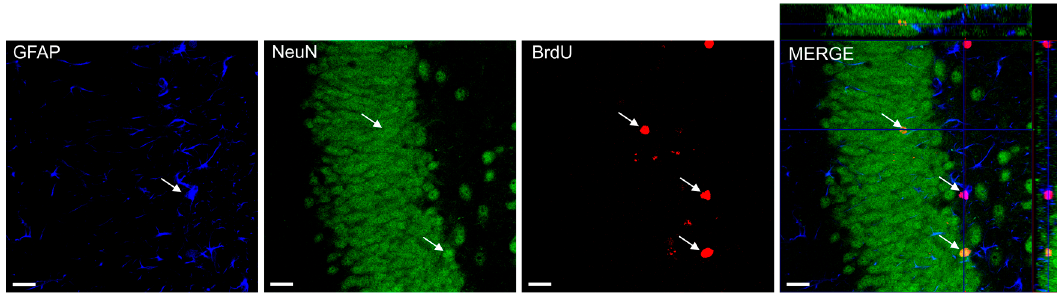
Figure 6. Bromodeoxyuridine (BrDU) positive cells in colocalization with NeuN and GFAP cells. The number of BrdU positive cells displaying astrocyte-specific (GFAP), neuron-specific (NeuN), BrDU-specific markers was determined using confocal microscopy to score the colocalization of BrdU and phenotypic indicators (MERGE-in orthogonal views) in representative sections from each animal. MERGE shows Z -axis projections of 23 µm × 1.32 µm. Bars: 20 µm.